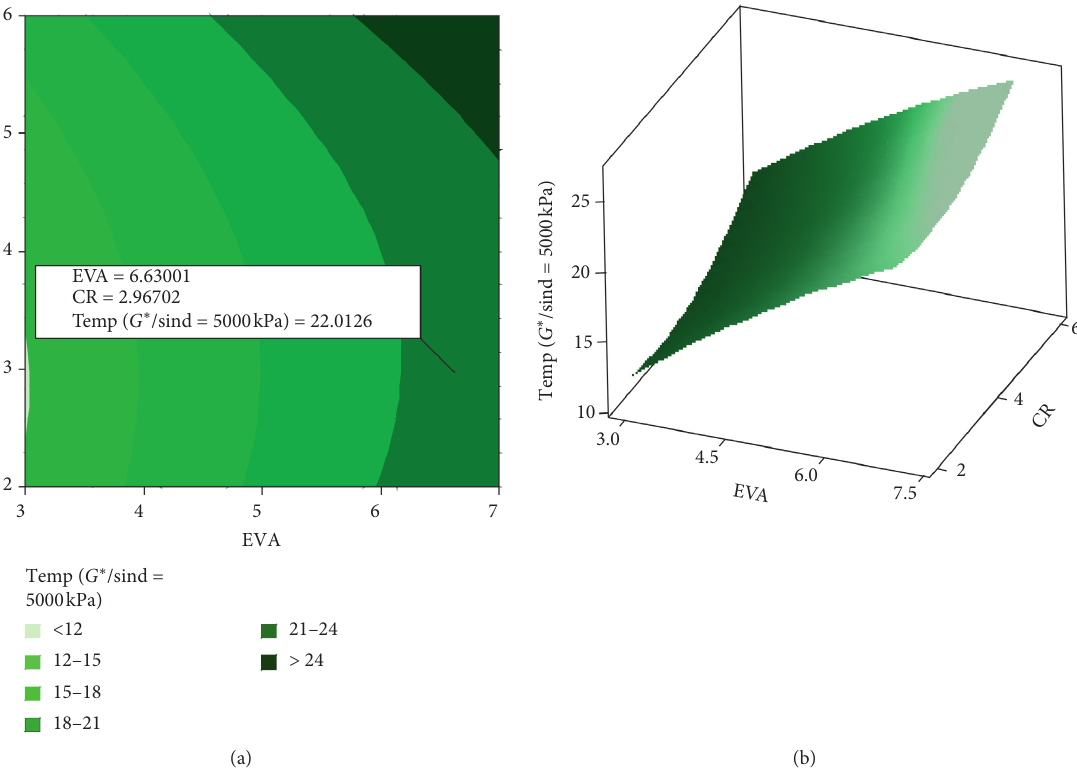
Figure 4: Contour plot of DSR test (fatigue factor). (a) Contour plot of temp ( G ∗ /Sin d ≤ 5000kPa) vs. CE and EVA. (b) Surface plot of temp ( G ∗ /Sin d ≤ 5000kPa) vs. CE and EVA.